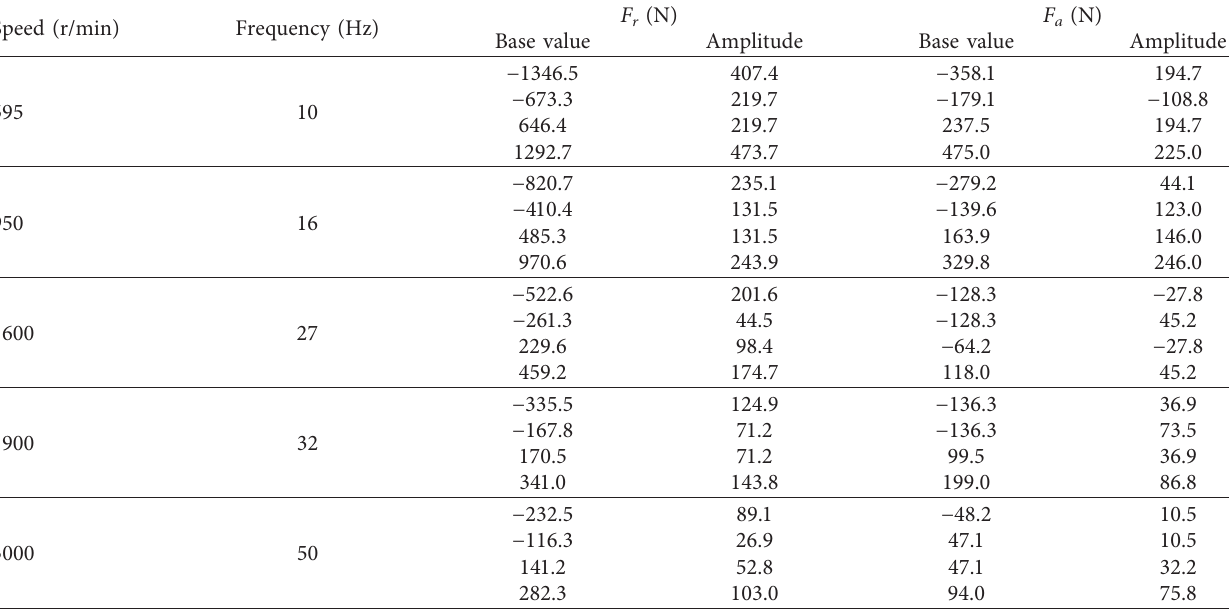
Table 1: Main parameters of the